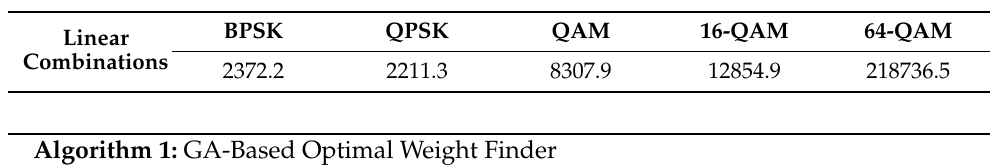
Table 2. LC of HOC’s.